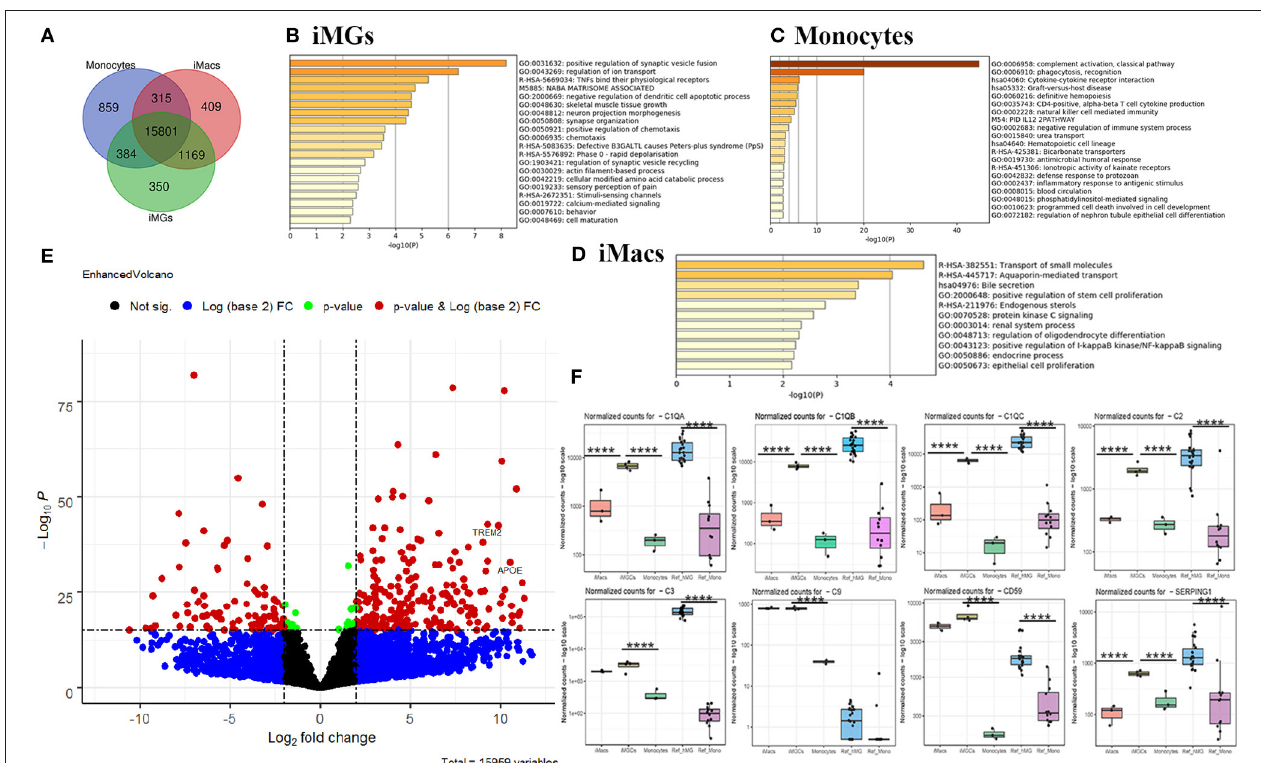
FIGURE 6 | Venn and differential expression analysis and enrichment analysis. (A) Venn diagram of genes expressed by iMG cells, iMacs, and monocytes (defined by the mean of the normalized counts > 10). Blue: Monocytes; Red: iMacs; Green: iMG cells. Enrichment analysis with the unique genes expressed in iMG cells (B) , monocytes (C) , and iMacs (D) , ranked by pathway p -value. (E) Volcano plot depicting differentially expressed genes in iMG cells against monocytes. The dashed line indicated p < 1 × 10 − 16 (horizontal line) and |log2FC| > 2 (Vertical line). Two well-known AD risk genes, APOE and TREM2 , were both upregulated in iMG cells as labeled in the Volcano plot. (F) Relative expression of significant genes ( C1QA, C1QB, C1QC, C2, C3, C9, CD59 , and SEPRING1 ) from the complement system in iMG cells vs. monocytes, and iMacs and. p values were obtained from differential expression analysis DESeq2 v1.28.1, where **** denotes p <